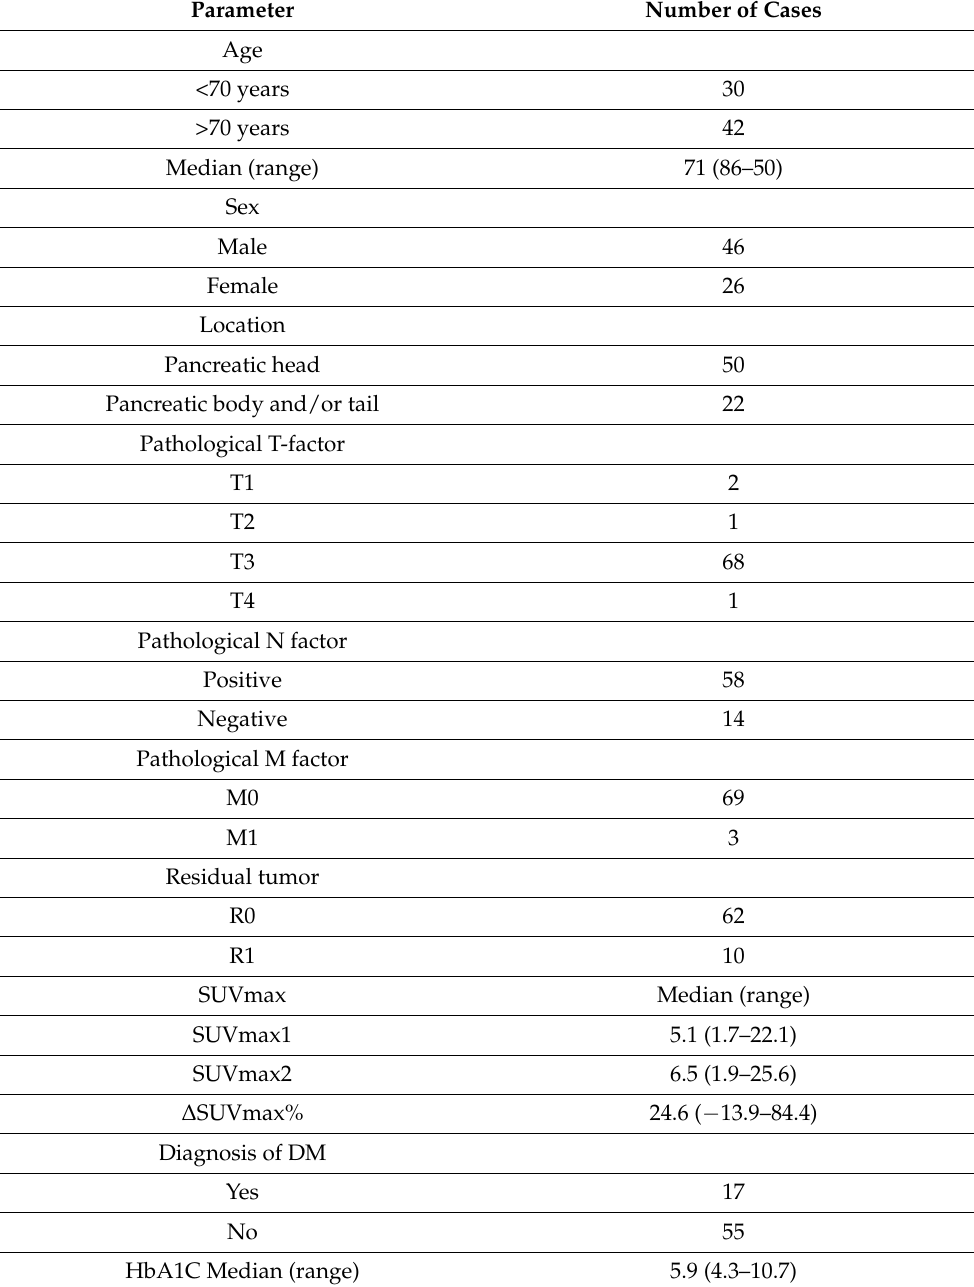
Table 1. Patient